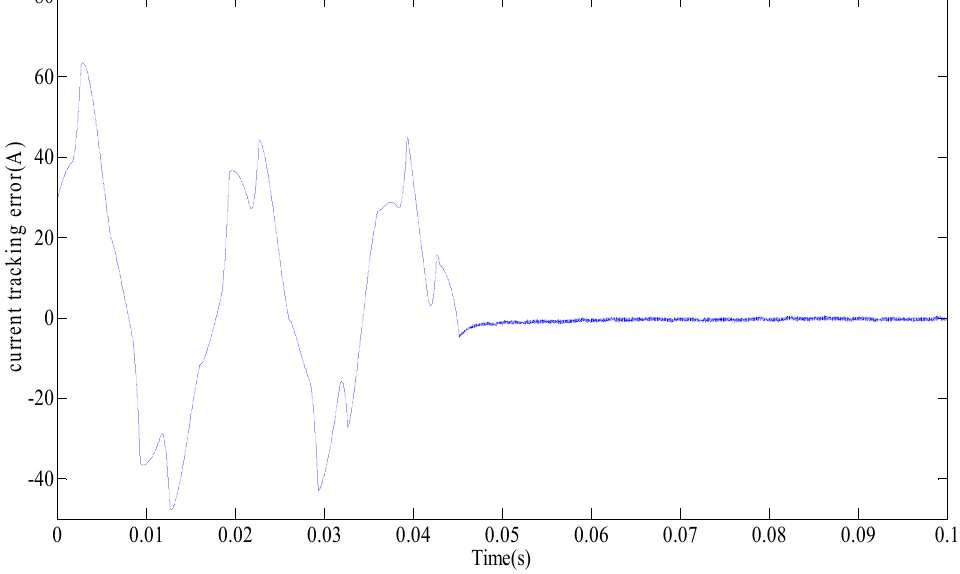
Figure 6. Compensation current tracking error.